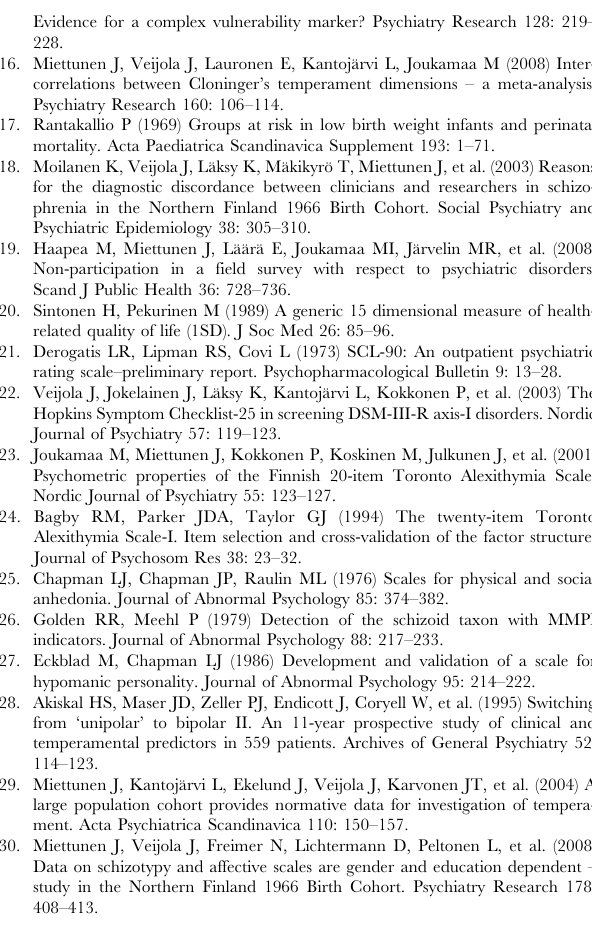
Figure S1 Histograms of chi-square values. Chi-square values of 100 experiments using generated data and of results based on cross-tabulation of 4-cluster solutions (presented in Table S2), with green for females and red for males. Table S1 Clusterings based on NFBC66 four-cluster model vs. YF two-cluster mode.